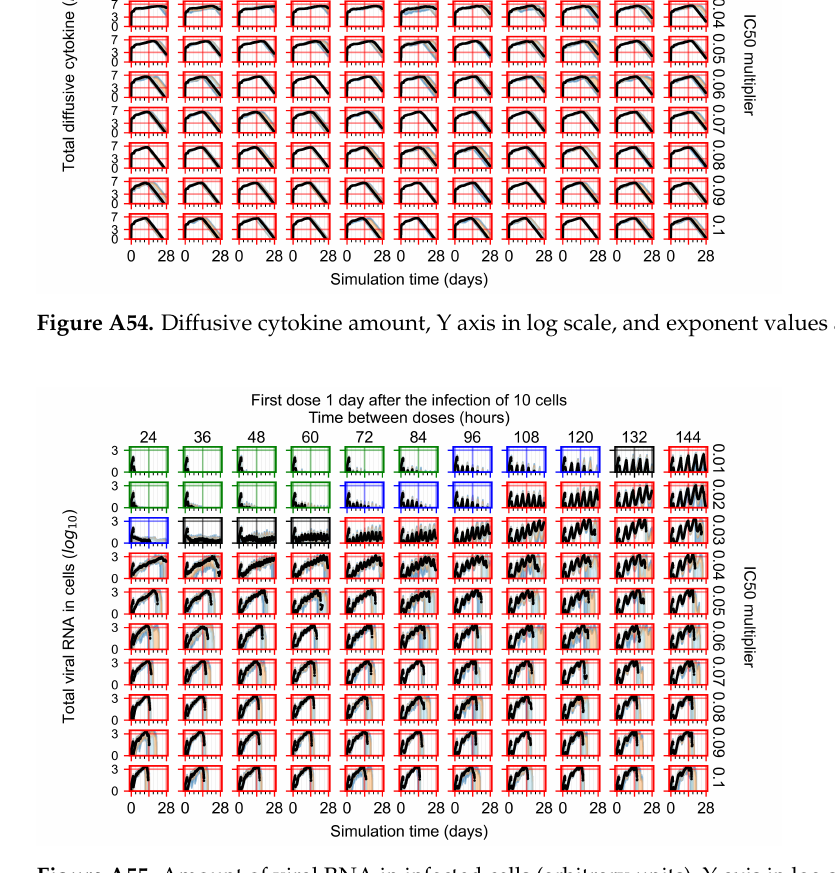
Figure A55. Amount of viral RNA in infected cells (arbitrary units), Y axis in log scale, and exponent values as tick